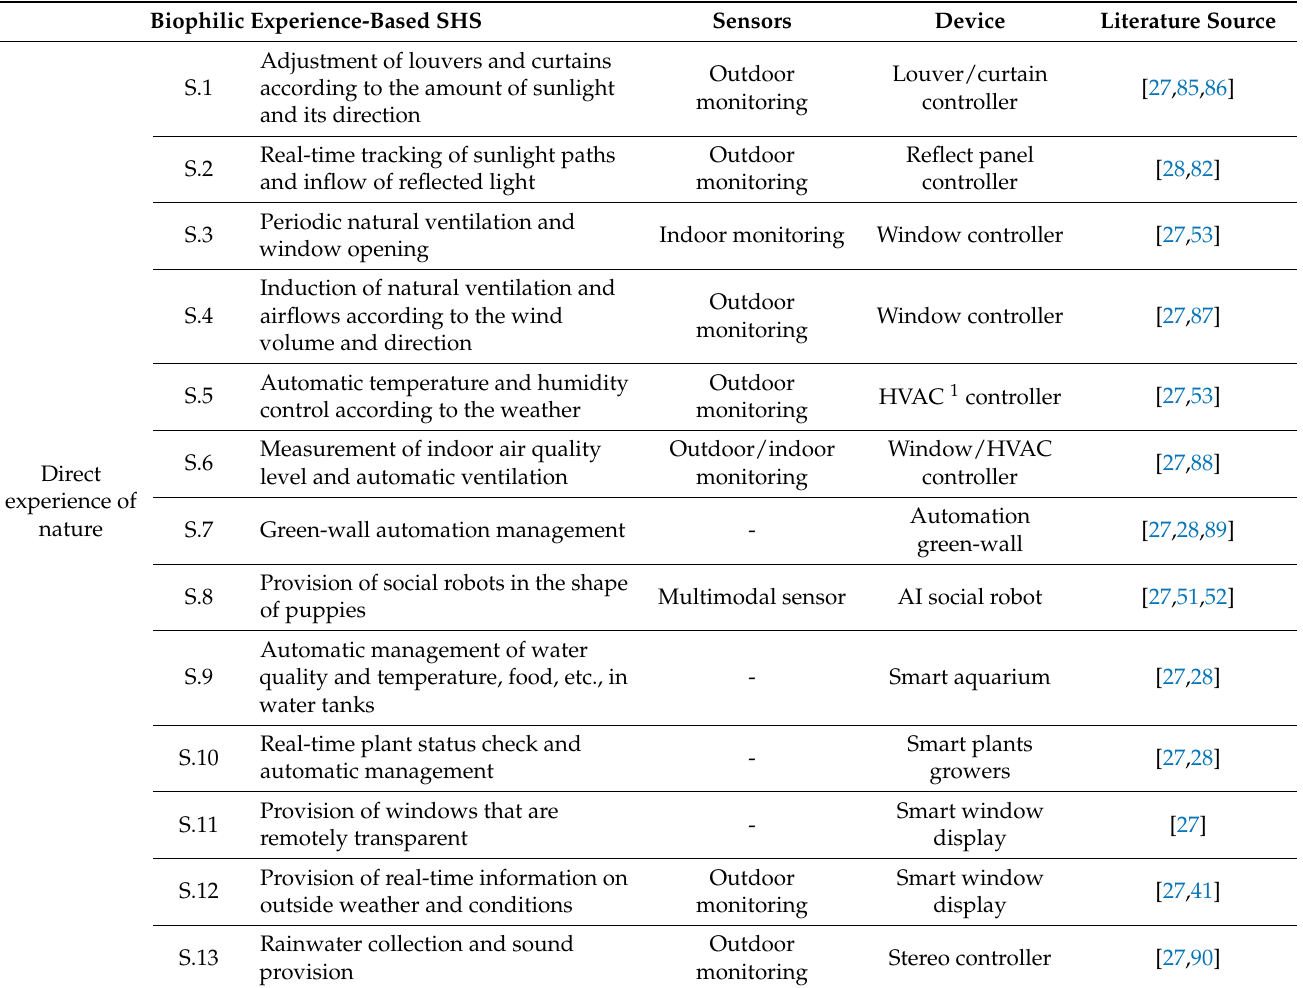
Table 2. Biophilic experience-based service configuration of smart home for the elderly. Biophilic Experience-Based SHS Sensors Device Literature